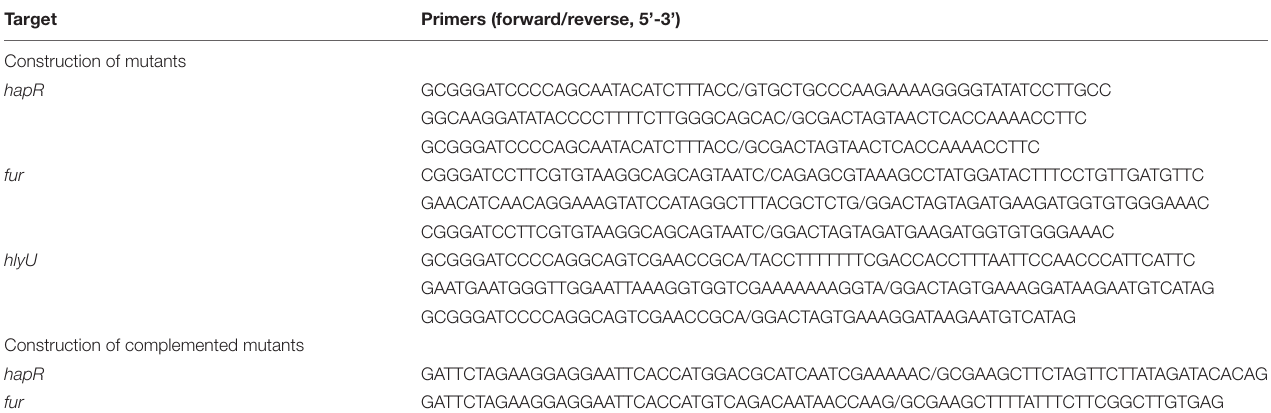
TABLE 1 | Oligonucleotide primers used in this